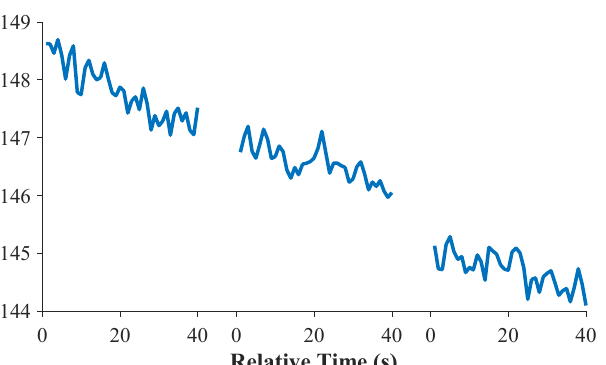
Figure 4. The course of computed R rs during ventilation of the respiratory system model with added resistor Rp5 (three 40 s long measurements correspond to measurement sections 4, 5, and 6 in Figure 2). Three glass demijohns with different compliance (37, 24, and 17 mL/cmH 2 O) were ventilated to investigate the effect of compliance on the measured resistance of the respiratory system.